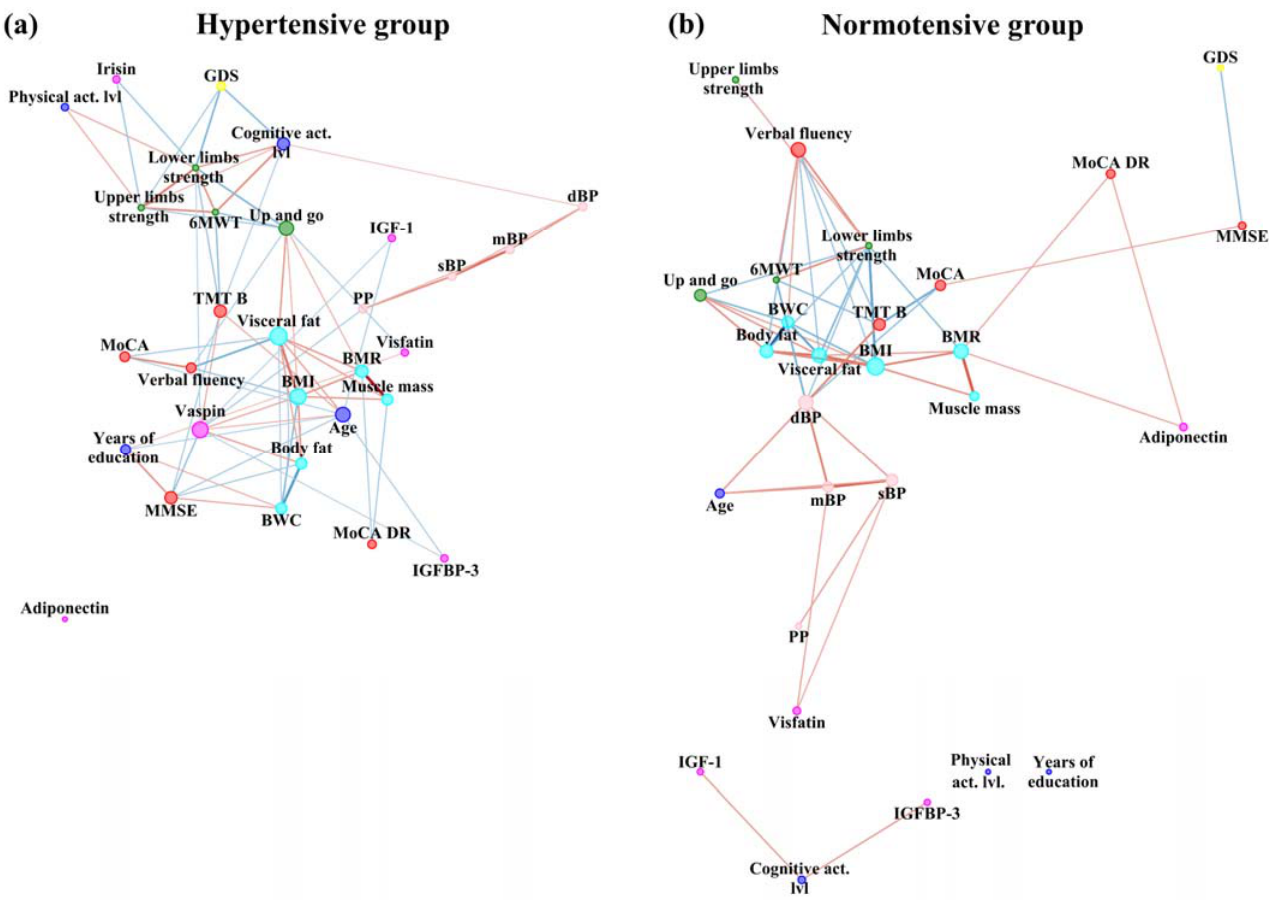
Figure 1. Network analysis comparison in PMHTN and NTN groups. PMHTN group network is presented on left side ( a ), NTN group on the right side ( b ). sBP—systolic blood pressure, dBP— diastolic blood pressure, mBP—mean blood pressure, PP—pulse pressure, MMSE—Mini–Mental State Examination, MoCA—Montreal Cognitive Assessment, MoCA DR—Montreal Cognitive Assessment Delayed Recall, TMT B—Trail Making Test part B, BMR—Basal Metabolic Rate, BWC—Body Water Content, BMI—Body Mass Index, 6MWT—six-minute walk test, IGF-1—Insulin-like growth factor 1, GDS—Geriatric Depression Scale.